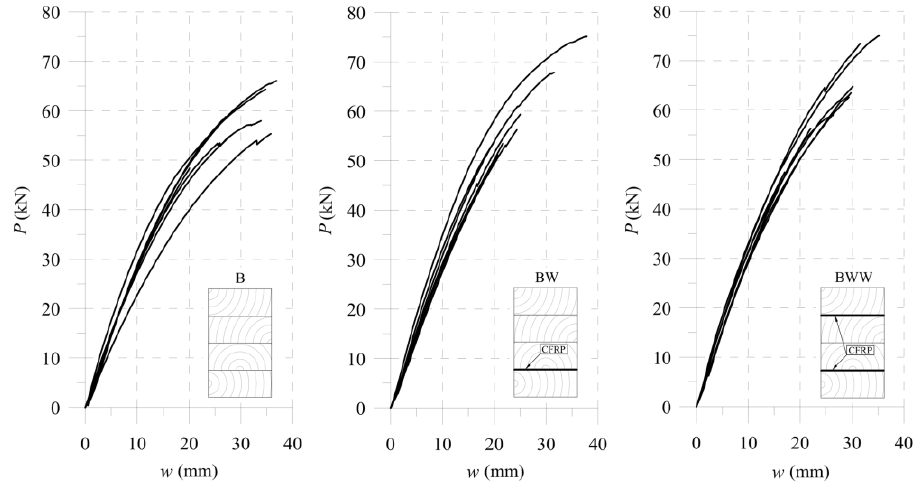
Figure 20. Laboratory tests results for full-scale girders.